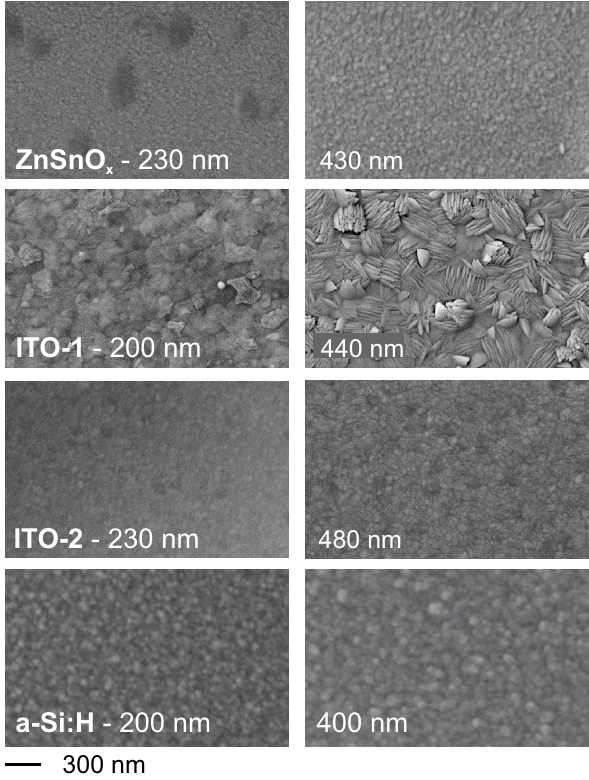
Figure 1. SEM images of zinc tin oxide (ZTO), indium tin oxide (ITO), and a-Si:H films for film thicknesses of 200nm and